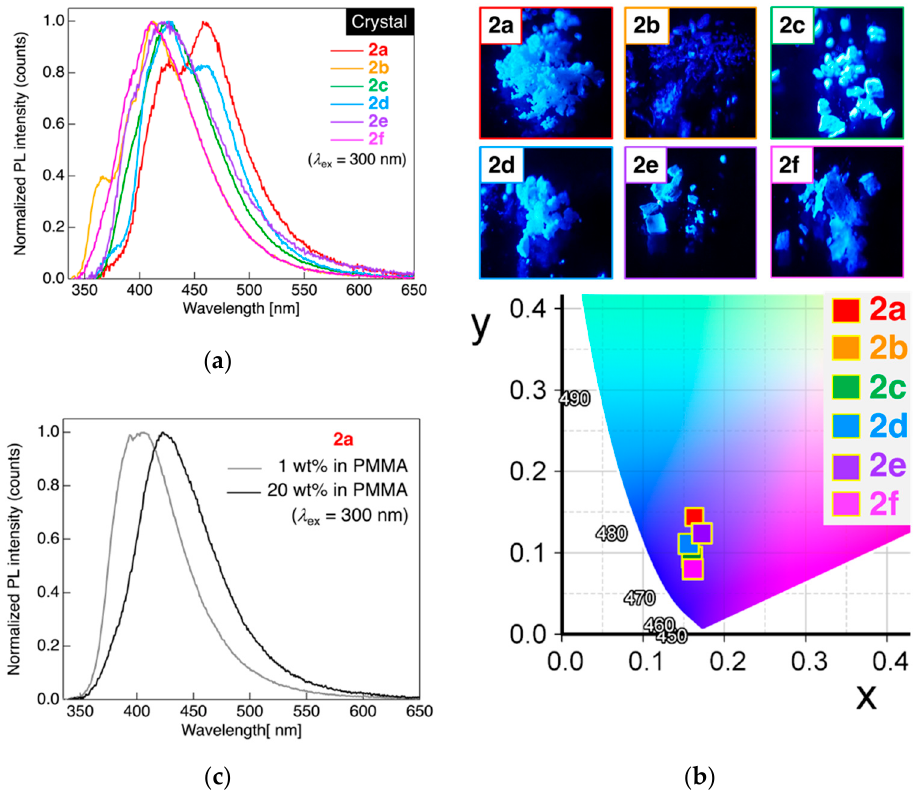
Figure 5. ( a ) PL spectra of dyads 2a – f in crystalline powder states. Excited at 300 nm light. ( b ) Photographs of the PL behavior of 2a – f in crystalline powder states and the CIE color diagram. ( c ) PL spectra of 2a blended in poly(methyl methacrylate). Excited at 300 nm